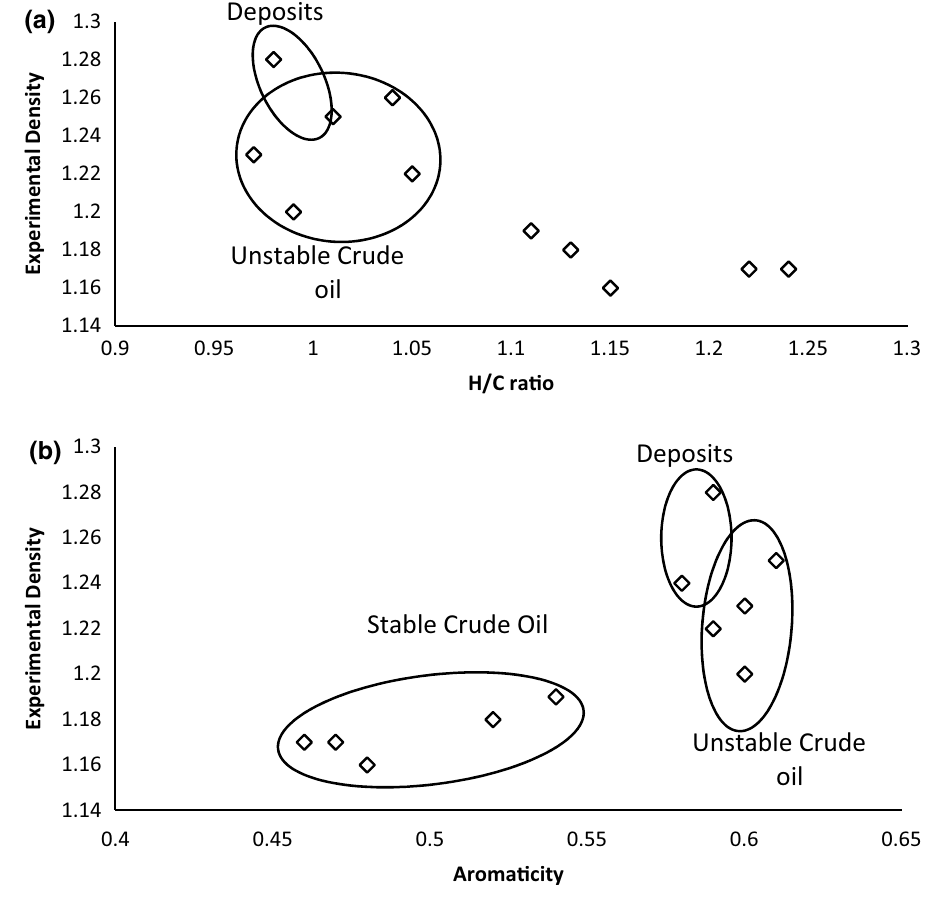
Fig. 5 Experimental densities as a function of a H / C ratio. b Aromaticity of